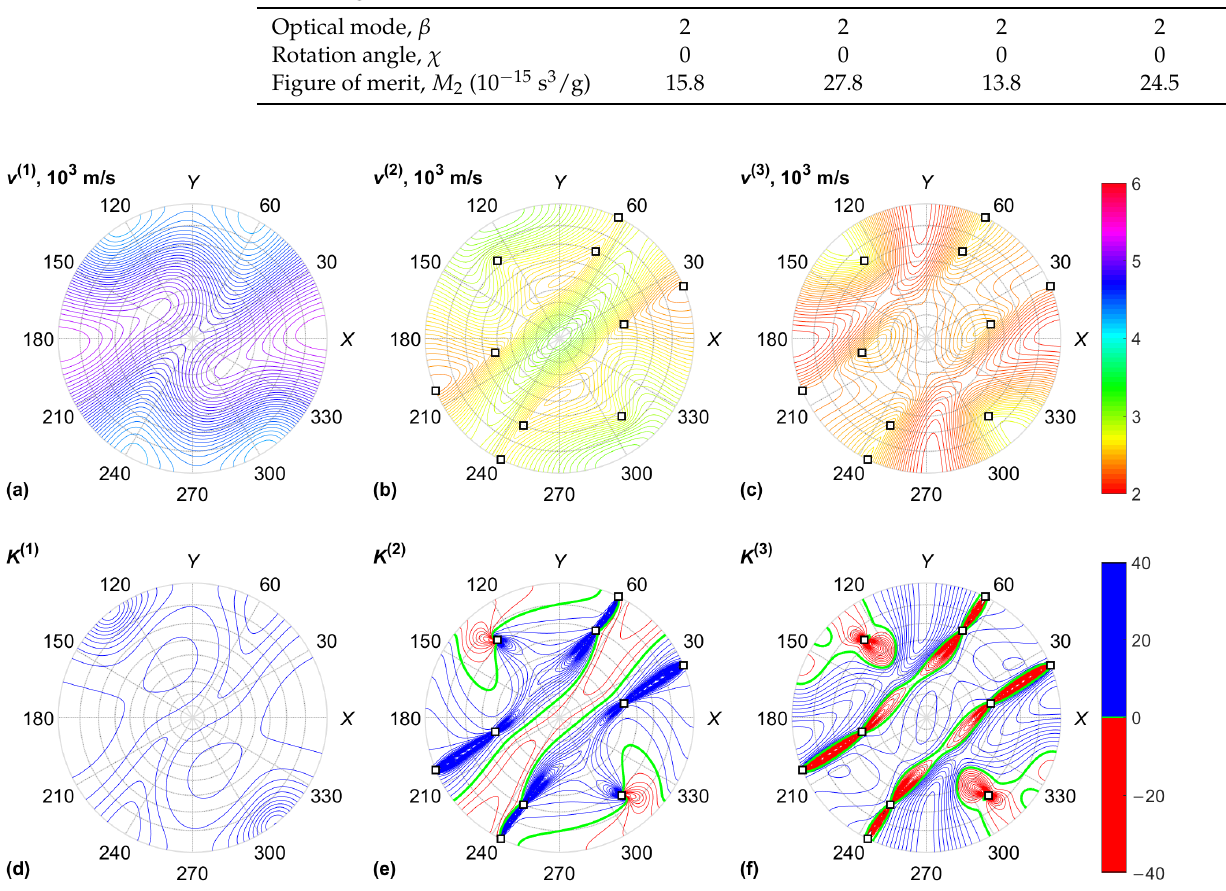
Figure 3. KGW crystal, acoustic properties: ( a ) QL BAW mode velocity; ( b ) fast QS BAW mode velocity; ( c ) slow QS BAW mode velocity; ( d ) QL BAW diffraction coefficient; ( e ) fast QS BAW diffraction coefficient; ( f ) slow QS BAW diffraction coefficient. Conical acoustic axes of the crystal are marked with